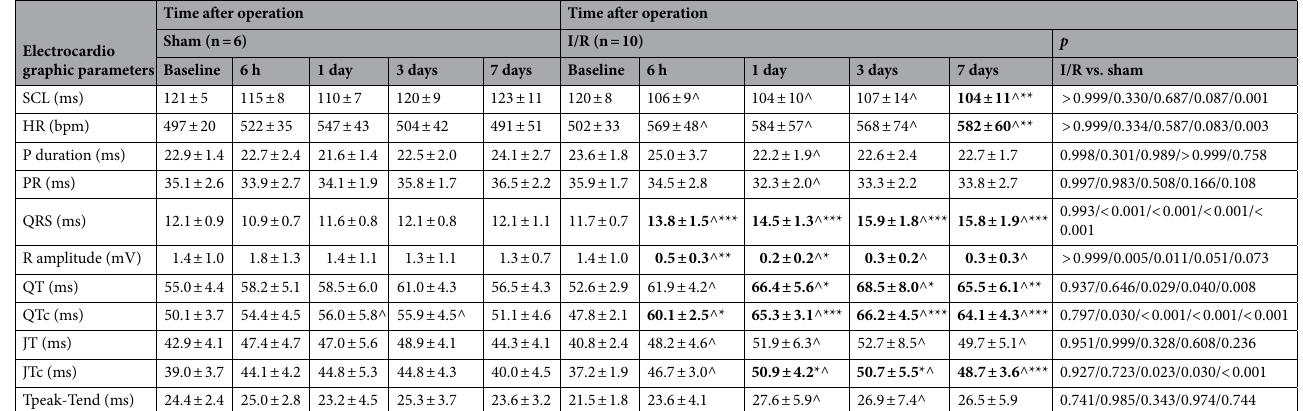
Table 2. Heart rate increases with prolonged ventricular depolarization and repolarization after I/R. Data are given as mean ± SD. Statistical significance of differences between I/R and sham control was assessed by two- way ANOVA (Sidak); * p < 0.05; ** p < 0.01; *** p < 0.001. The change of parameters after incident compared to baseline of each group was assessed by two-way ANOVA (Dunnett); ^ p < 0.05. Significant values are in